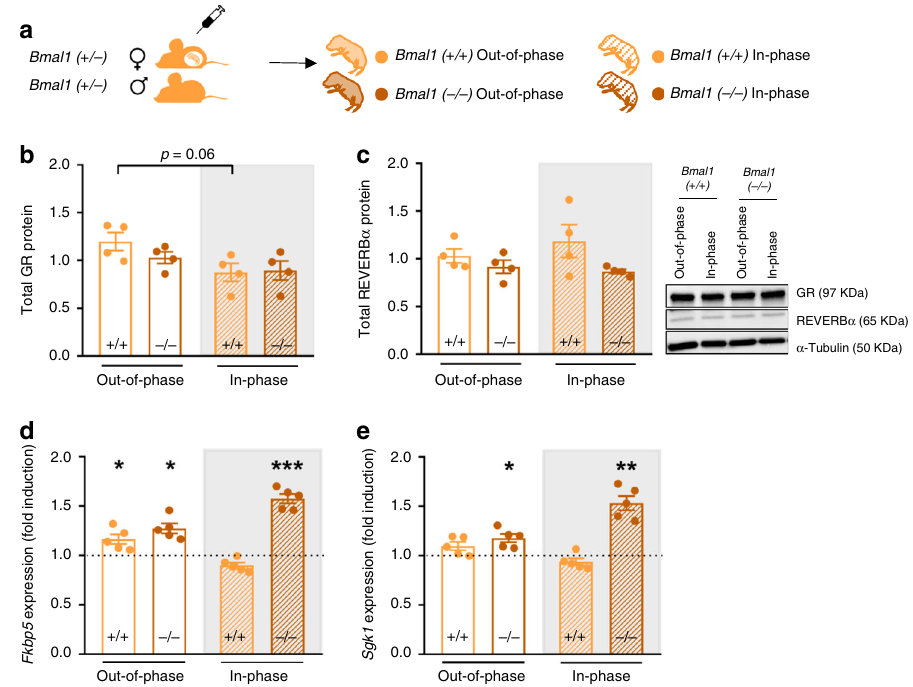
Fig. 5 The fetal hypothalamic clock controls GC sensitivity through expression of REVERB α . a Brain and muscle aryl hydrocarbon receptor nuclear translocator-like 1 ( Bmal1 − / − and Bmal1 + / + ), clock de fi cient and wild-type fetus, respectively were obtained from mating Bmal1 + / − heterozygous couples aiming to test the clock-dependent induction of hypothalamic glucocorticoid receptor (GR) targets after corticosterone (CORT) injection. b , c GR and Reverse erythroblastoma alpha (REVERB α ) protein in fetal hypothalami (out-of-phase Zeitgeber time (ZT)1 Bmal1 + / + and − / − , in-phase ZT13 Bmal1 + / + and − / − , n = 4 for all groups). Representative Western blot results are shown; samples were run in duplicates and α -Tubulin was used as loading control. d , e mRNA relative expression of the GR targets FK506 binding protein 5 ( Fkbp5 ) and Serum glucocorticoid-regulated kinase 1 ( Sgk1 ) in the hypothalami of fetus from CORT injected Bmal1 − / + mothers mated to males of the same genotype. The dotted line represents the expression levels of fetus from naive mothers of the respective genotype and time point (naive and out-of-phase ZT1 Bmal1 + / + and − / − , naive and in-phase ZT13 Bmal1 + / + and − / − , n = 5 for all groups). qPCRs for gene expression were run in duplicates. All data are expressed as means ± SEM. In b data were analyzed by two-sided Mann – Whitney test ( b ) out-of-phase ZT1 vs out-of-phase ZT13, p = 0.06. In d , e data were analyzed by two-sided unpaired t -test ( d Fkbp5 : naive ZT1 + / + vs out-of-phase ZT1 + / + , t = 2.22, df = 8, p = 0.05; naive ZT1 − / − vs out-of-phase ZT1 − / − , t = 2.33, df = 8, p = 0.04; naive ZT13 − / − vs in-phase ZT13 − / − , t = 6.53, df = 8, p = 0.0002; e Sgk1 : naive ZT1 − / − vs out- of-phase ZT1 − / − , t = 2.80, df = 8, p = 0.02; naive ZT13 − / − vs in-phase ZT13 − / − , t = 4.23, df = 8, p = 0.002). * p <0.05, ** p <0.01, *** p <0.001. Source data are provided as a Source Data fi